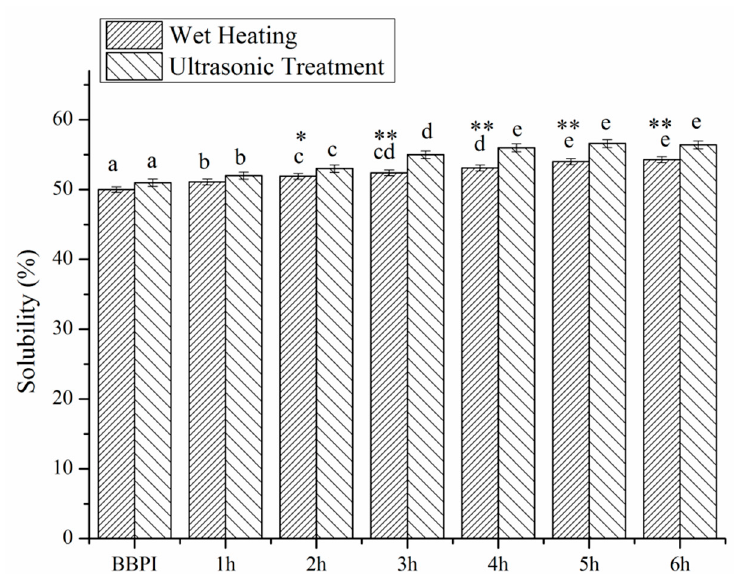
Figure 4. Solubility of BBPI by wet heating and ultrasound treatment Maillard reaction obtained after 1–6 h, respectively. Means with dissimilar lower-case letters indicate significant differences ( P < 0.05), ** means in the same time P < 0.01, * means in the same time P <